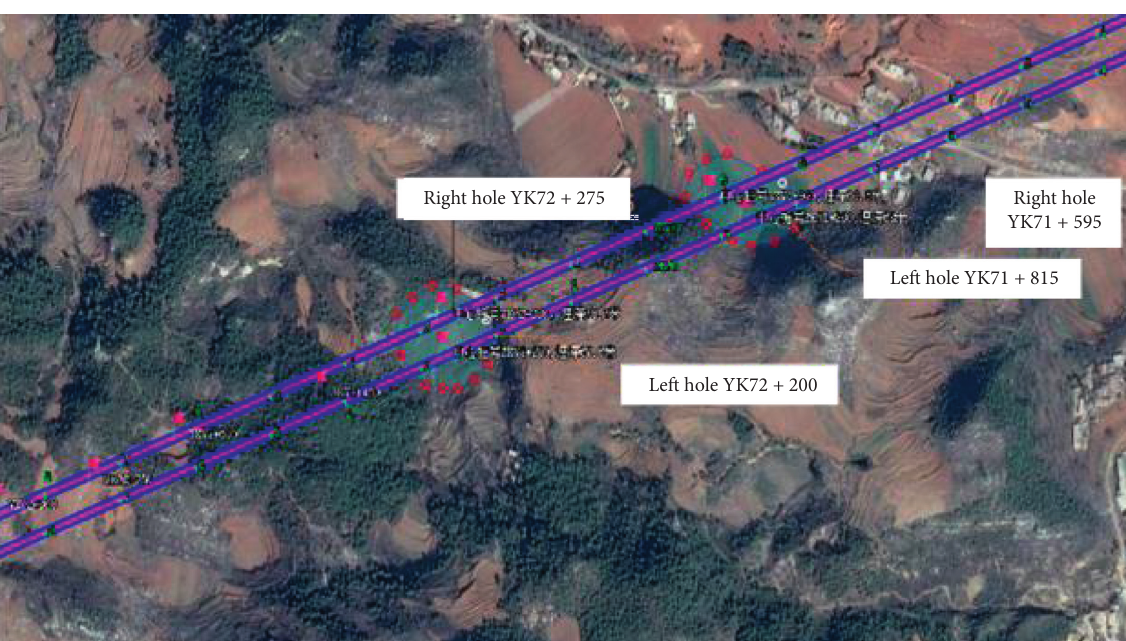
Figure 3: The route of the Jiguan Mountain